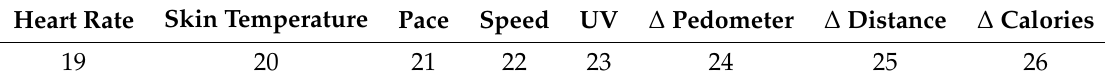
Table 4. Feature vector structure (Fields 19 to